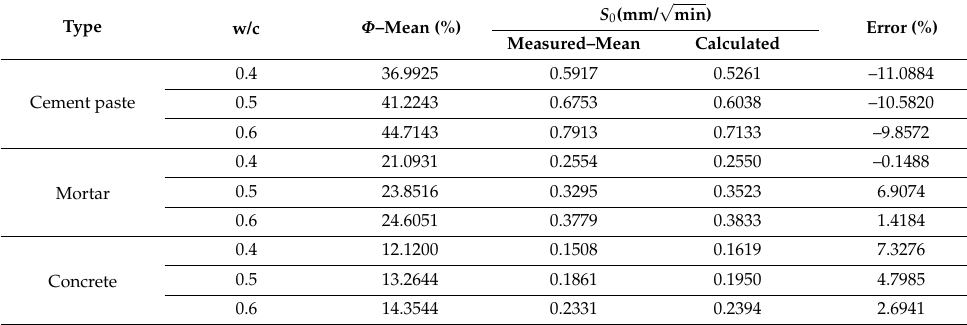
Table 5. Comparison of the measured and calculated